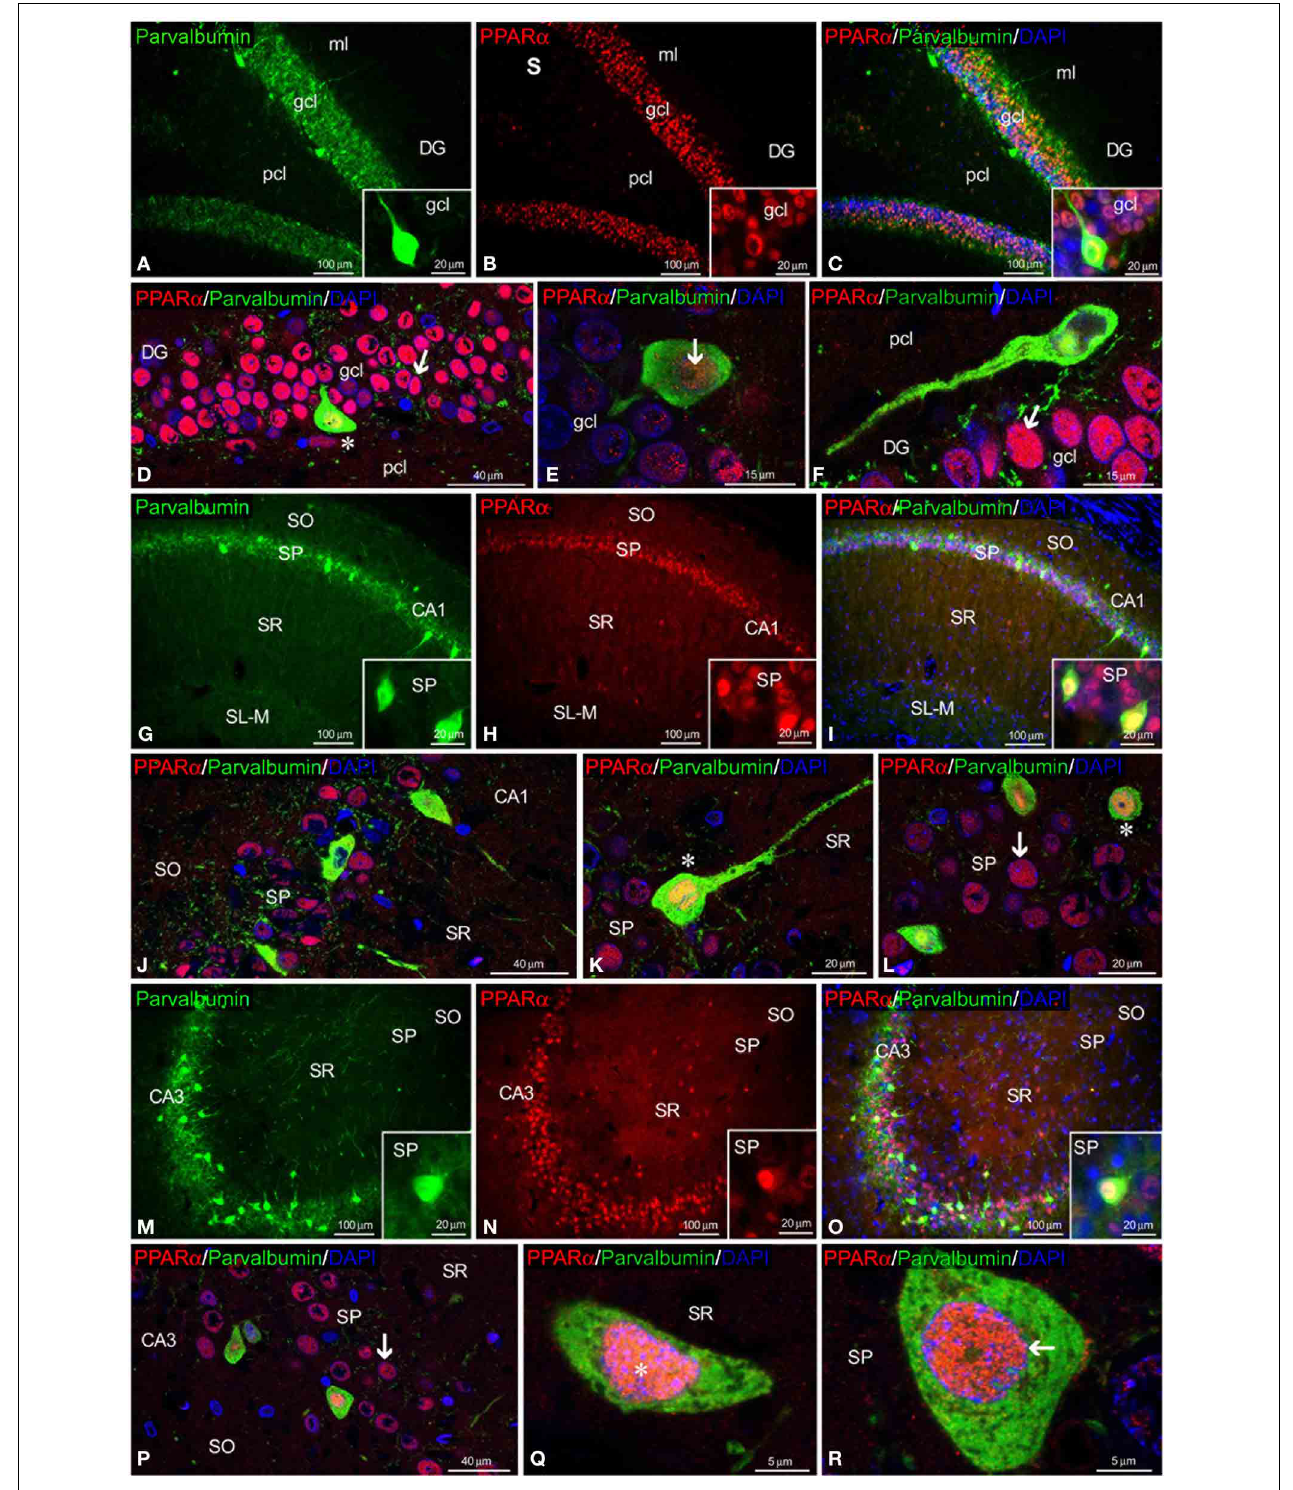
FIGURE 5 | PPAR α and parvalbumin co-expression in the rat hippocampus. Low-resolution epifluorescence photomicrographs (A–C,G–I,M–O) and high-resolution confocal laser scanning photomicrographs (D–F,J–L,P–R) showing the labeling of parvalbumin (green) and PPAR α (red) in the dentate gyrus (DG), CA1, and CA3